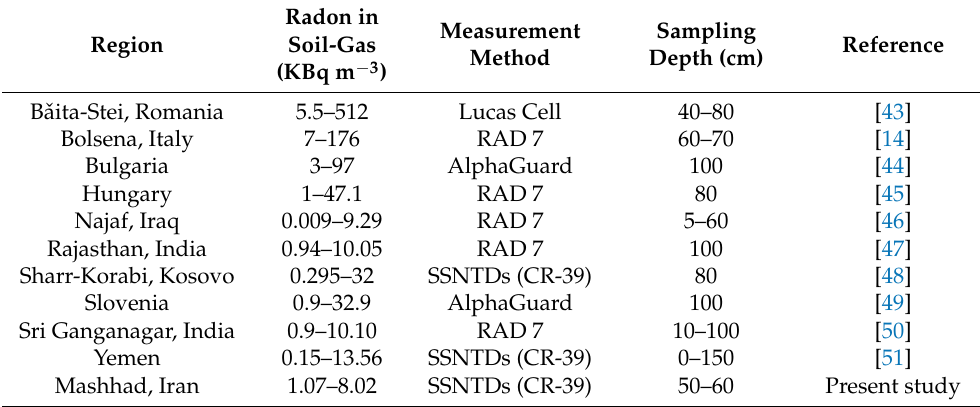
Table 2. Comparison of soil-gas radon concentrations under investigation with those in other countries using different methods and sampling